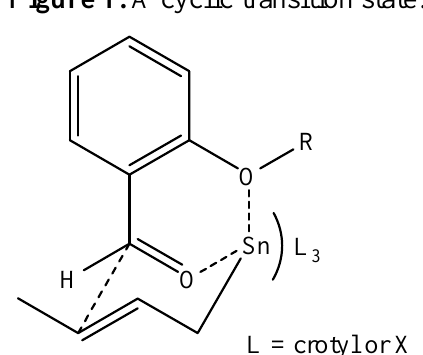
Figure 1. A cyclic transition